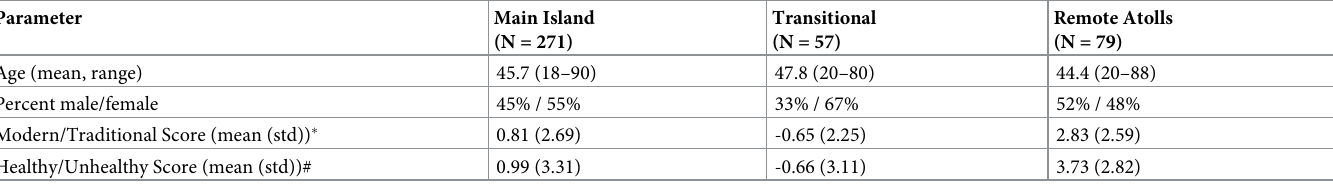
Table 2. Traditional-Modern and Healthy-Unhealthy scale scores of the three Pohnpeian study populations.